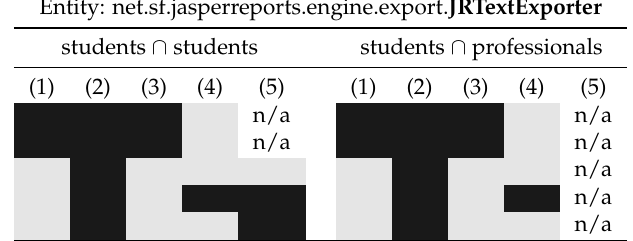
Table 3. An example of cross section between students and between students and professionals in categories general assessment (1), source code size (2), class complexity (3), class cohesion (4) and coupling with other classes